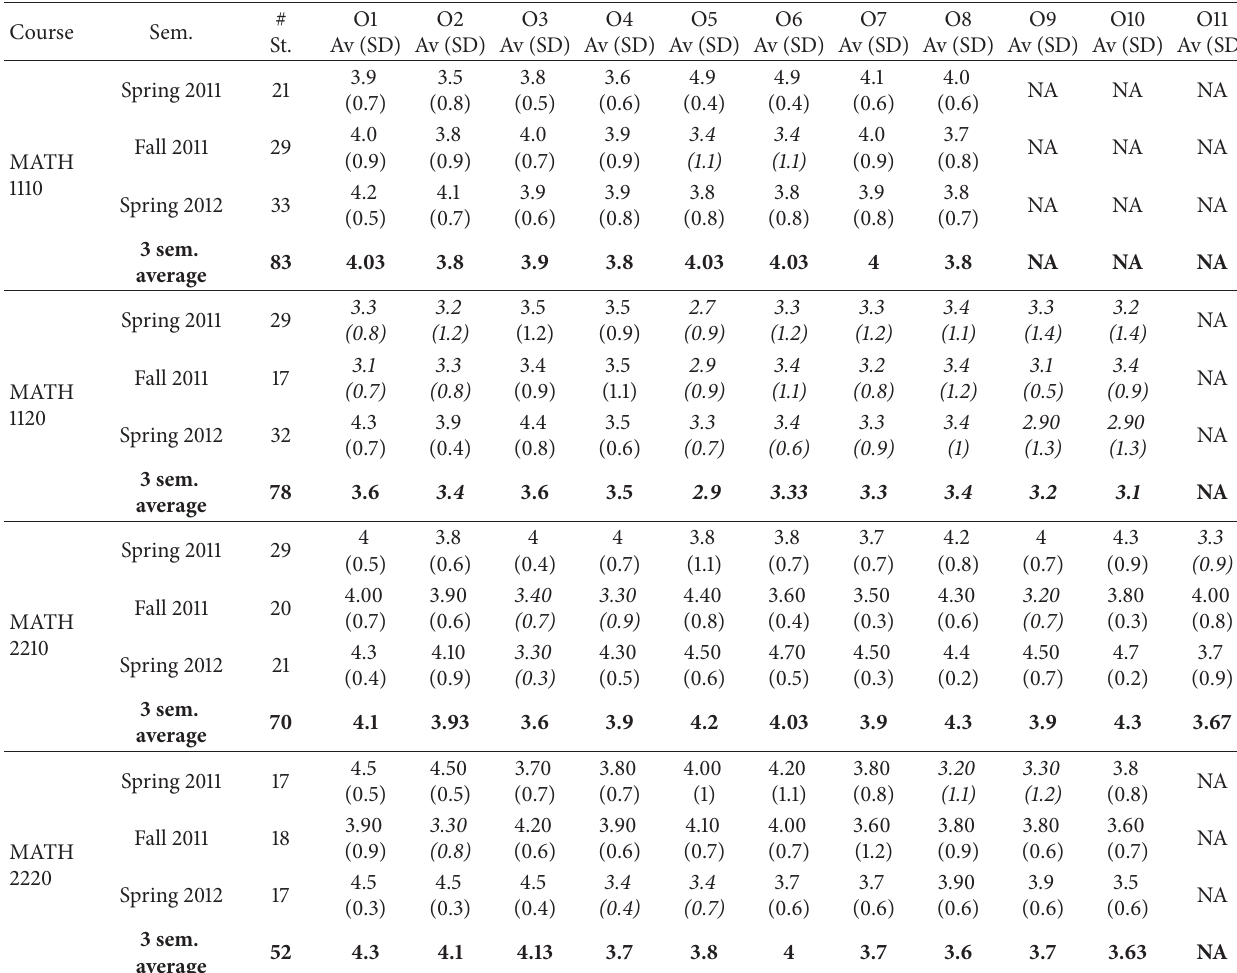
Table 7: Learning assessment of course outcomes based on the direct measures given in Tables 1–4 (NA: not applicable, Values in italic are below the outcomes-achievement passing